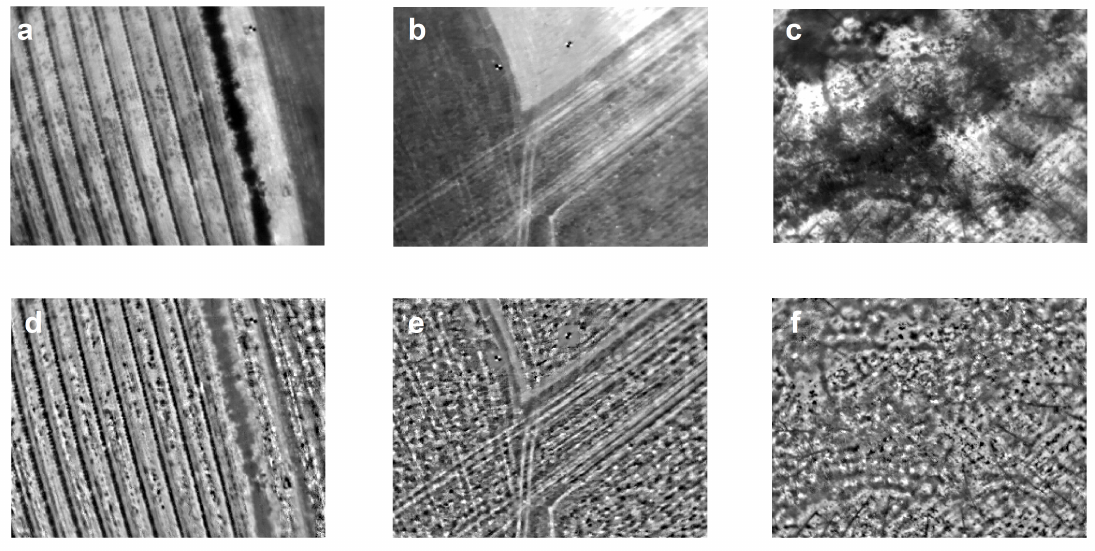
Figure A3. Example images for each land cover class. ( a ) Cropland, acquisition